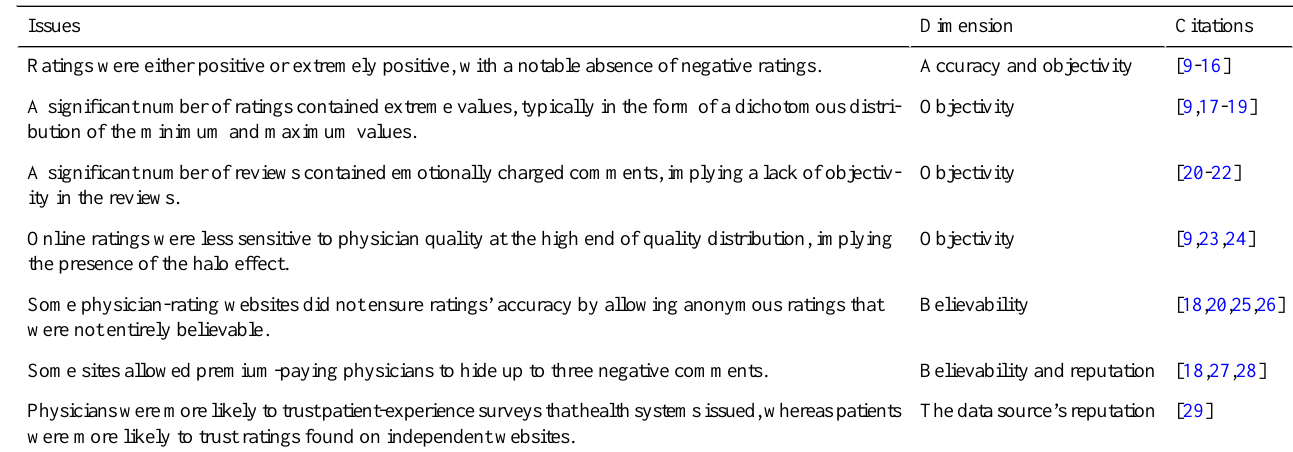
Table 2. Intrinsic data quality